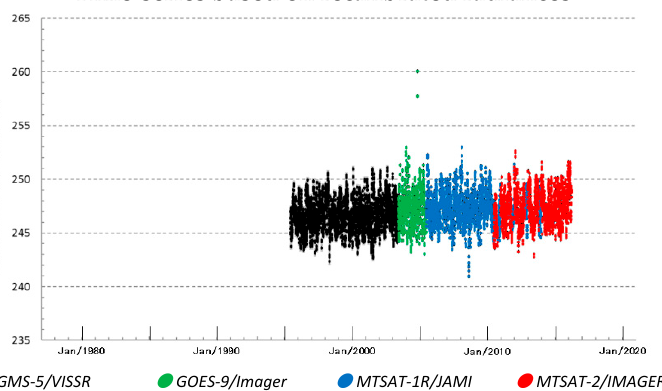
Figure 12. As Figure 11 but for the WV channel of GMS-5, GOES-9, MTSAT-1R and MTSAT-2. Table 6. Statistics of the operational and recalibrated baseline sensor normalized brightness temperatures (K) for the WV and IR channel of the JMA satellites. The statistics are given as average and standard deviation (given in brackets).